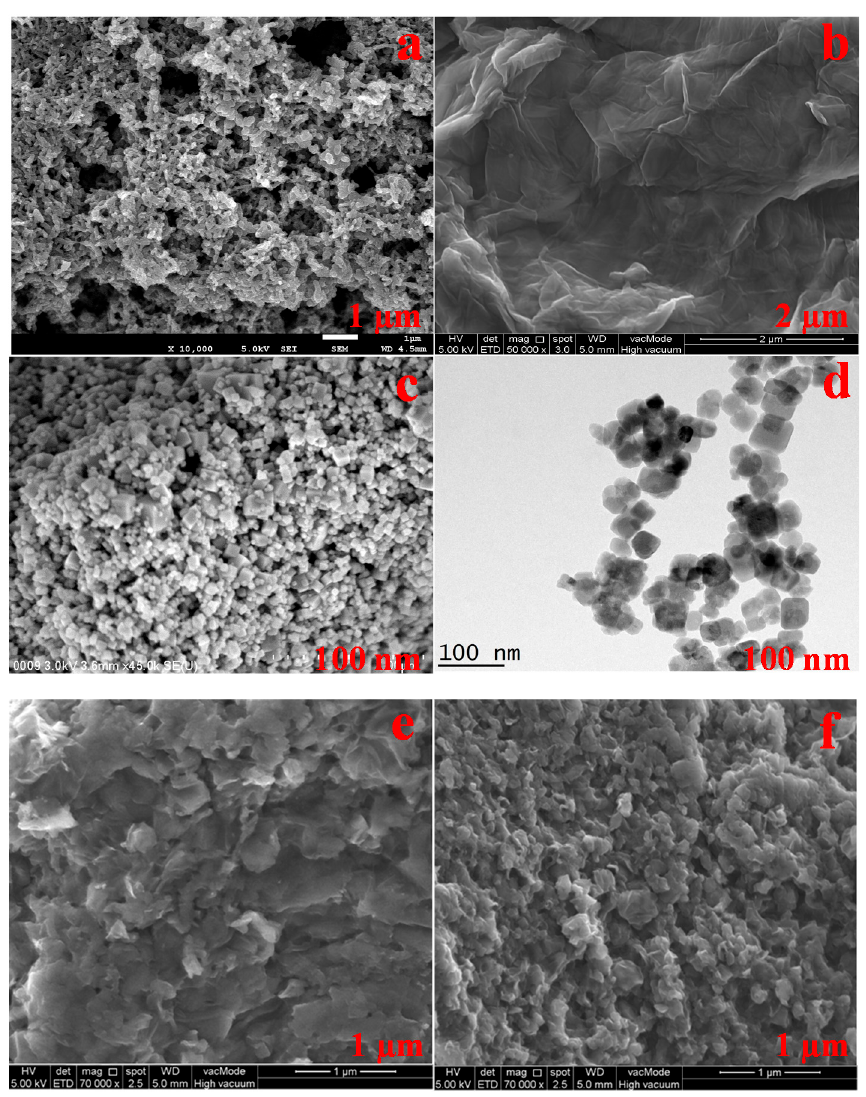
Figure 1. FESEM micrographs of ( a ) PANI; ( b ) GO; ( c ) SrTiO 3 nanocubes; ( e ) GOPSr-0; and ( f ) GOPSr-2 nanocomposite; and ( d ) TEM image of SrTiO 3 nanocubes.